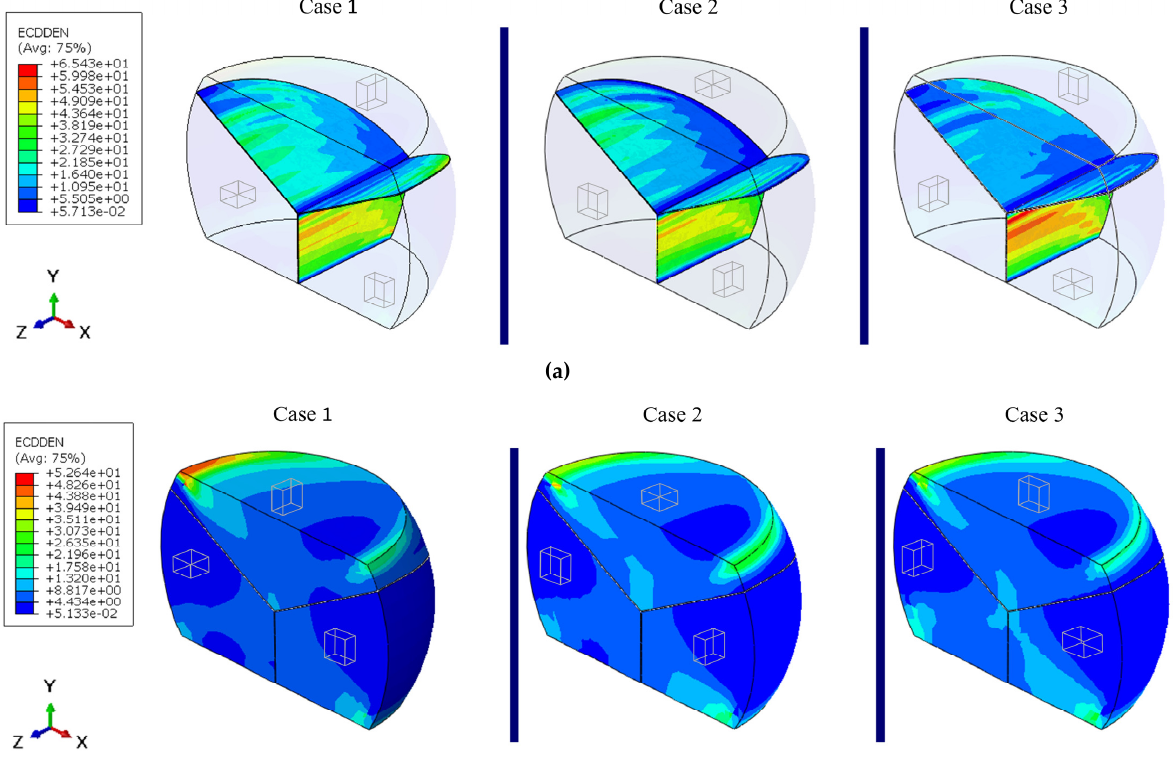
Figure 12. Contour plot of the creep work density dissipated at the end of the fourth cycle in the ( a ) grain boundaries (cohesive elements), and ( b ) grains.